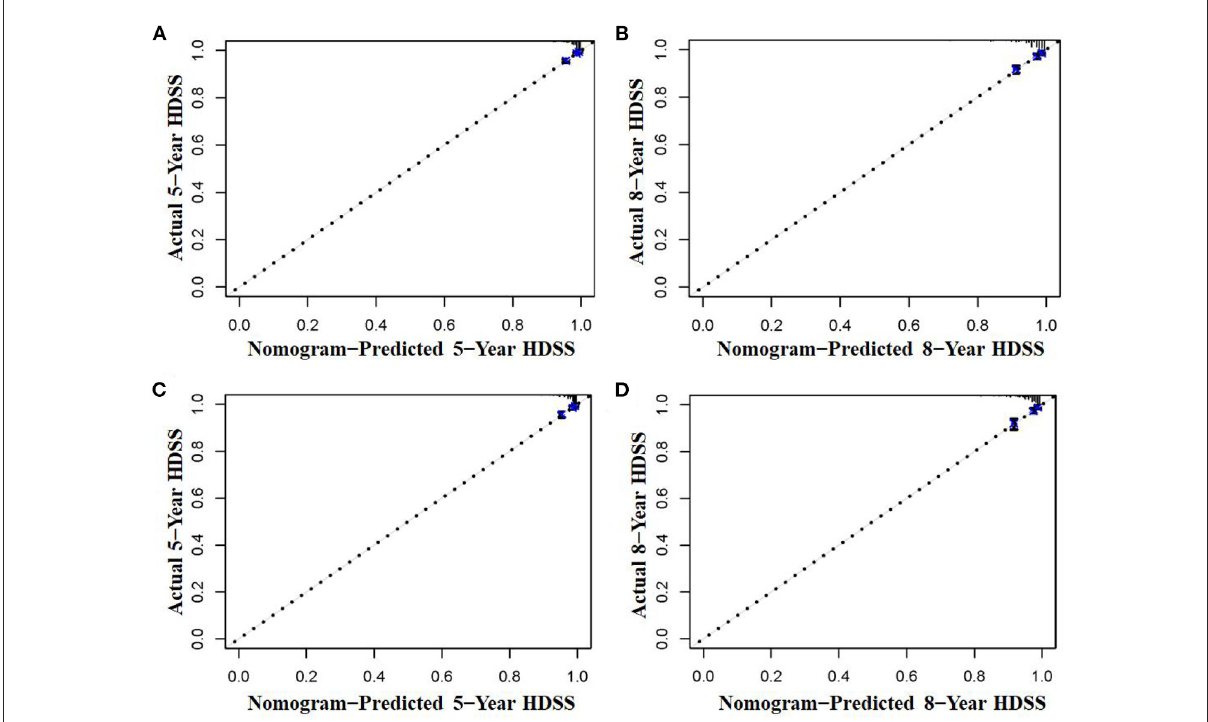
FIGURE3 The calibration curves of the nomogram were used to predict the 5- and 8-year HDSS in older female primary breast cancer patients that underwent chemotherapy in the training (A,B) and validation cohorts (C,D) .